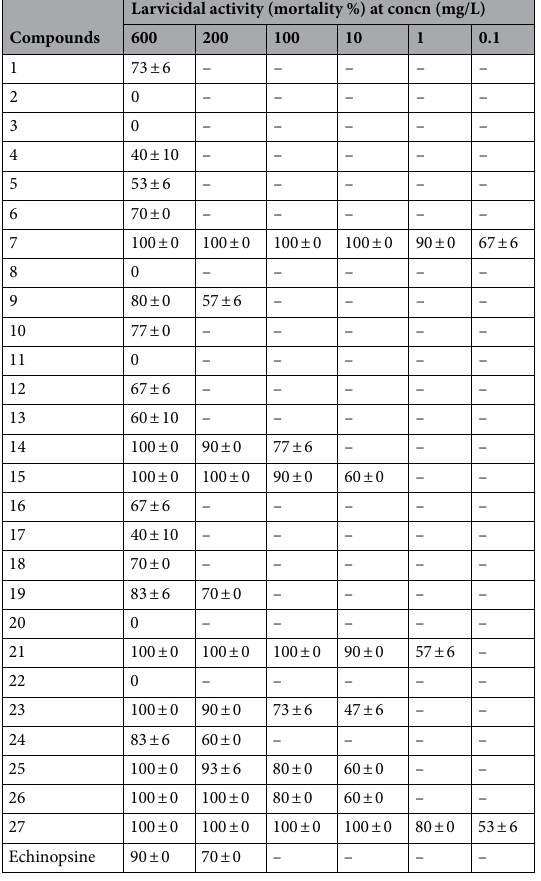
echinopsine (70 ± 0% at 200 mg/L). Especially, compounds 9 and 24 showed 20 ± 0% and 30 ± 0% mortality at 50 mg/L. In addition, the compounds 5 , 21 , 24 , and 25 showed much higher activities (100 ± 0% at 200 mg/L) against S. frugiperda than that of echinopsine (50 ± 0% at 600 mg/L). Especially, compounds 24 still showed 17 ± 6% mortality at 50 mg/L (Table 3). Fungicidal activity. The fungicidal results of compounds 1 – 27 and echinopsine are listed in Table 4. The commercial fungicide carbendazim and chlorothalonil were used as positive control. Overall, echinopsine and their derivatives exhibited broad-spectrum fungicidal activities against 14 kinds of phytopathogenic fungi. Most compounds showed relatively high fungicidal activities for Physalospora piricola and Sclerotinia sclerotiorum , among which the fungicidal activities of compounds 1 – 14 containing substituted phenyl were relatively higher than compounds 15 – 26 containing heterocyclic rings. Compound 13 and 14 showed more than 50% inhibitory rate against five and six fungi respectively. Compound 2 showed the widest spectrum of fungicidal activity, with more than 60% inhibitory rate against eight fungi. Compound 7 exhibits 89.0 ± 1.9% inhibitory rate against Rhizoctonia cerealis at 50 mg/L, higher than carbendazim and chlorothalonil. In summary, a series of novel echinopsine derivatives containing acylhydrazone moieties were designed, synthesized and their antiviral, insecticidal, and fungicidal activities were studied. The bioassays results showed that most compounds exhibited moderate to good anti-TMV activities in vivo, among which echinopsine (I) and its derivatives 1, 3, 7 showed higher anti-TMV activities than those of ribavirin, which can be used as lead structures for the development of anti-TMV drugs. Some compounds exhibited moderate to good insecticidal activity to P. xylostella , M. separata and S. frugiperda . In addition, most of these compounds exhibited good fungicidal activities against P. piricola and S. sclerotiorum . Further investigation on structural optimization and the mechanism of action are in progress in our laboratory.